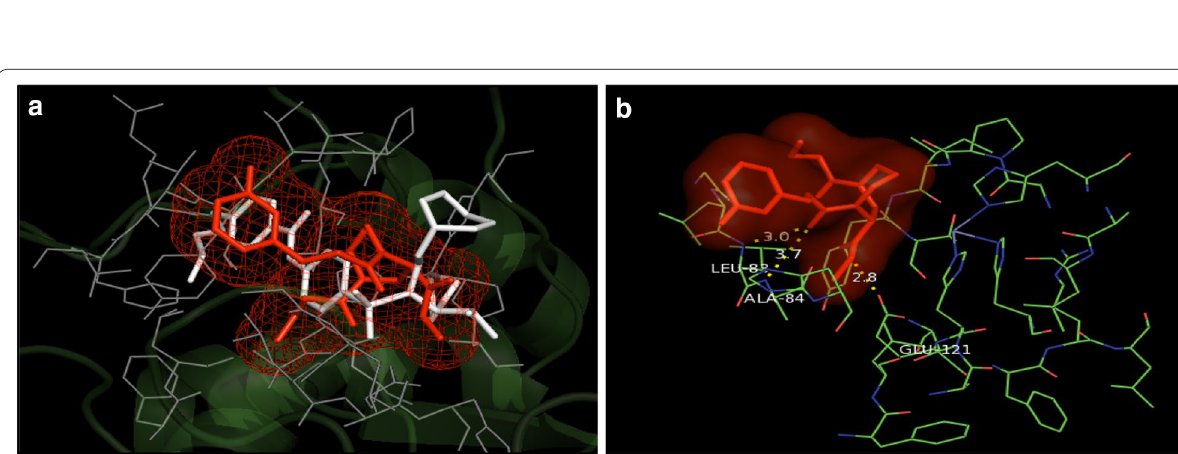
Fig. 5 a Overlay of the docked pose of compound 8 (red) with that of PDB Ligand 1HOV (white); b docked pose: H-bond interaction of compound 8 in the binding site of MMP-2